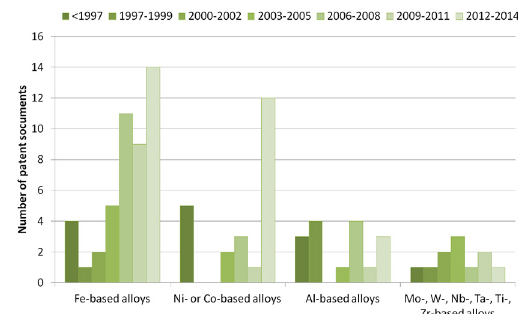
Figure 5. Number of patent documents in different periods for each main amorphous/glassy metallic alloys. Source: Derwent Innovations Index.